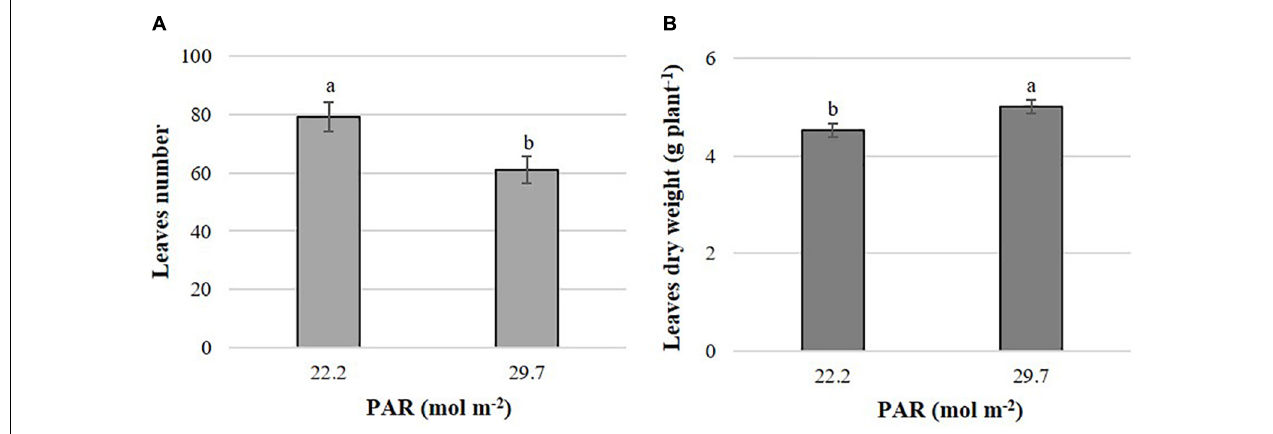
FIGURE 1 | Effects of mean daily photosynthetically active radiation (PAR) on leaf number (A) and leaf dry matter (B) in B. campestris cv. Mibuna Early. Means ± SD with different letters in each subfigure indicate significant differences at P ≤ 0.05 (Tukey’s test).